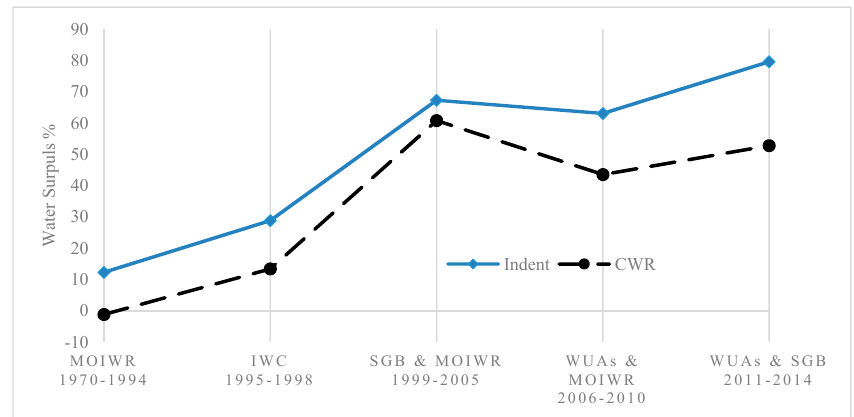
Figure 9. Water supply volume against Indent and CWR through the different periods.